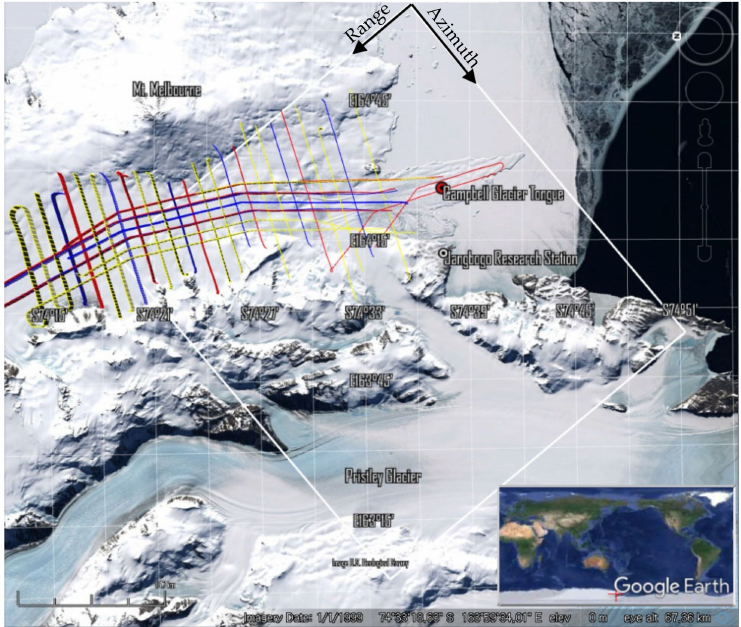
Figure 1. Map of the study area. The white rectangle is the COSMO-SkyMED SAR image area and the lines are the helicopter-borne IPR survey routes over Campbell Glacier with different colors of acquisition data quality: blue (good), yellow (poor), and red